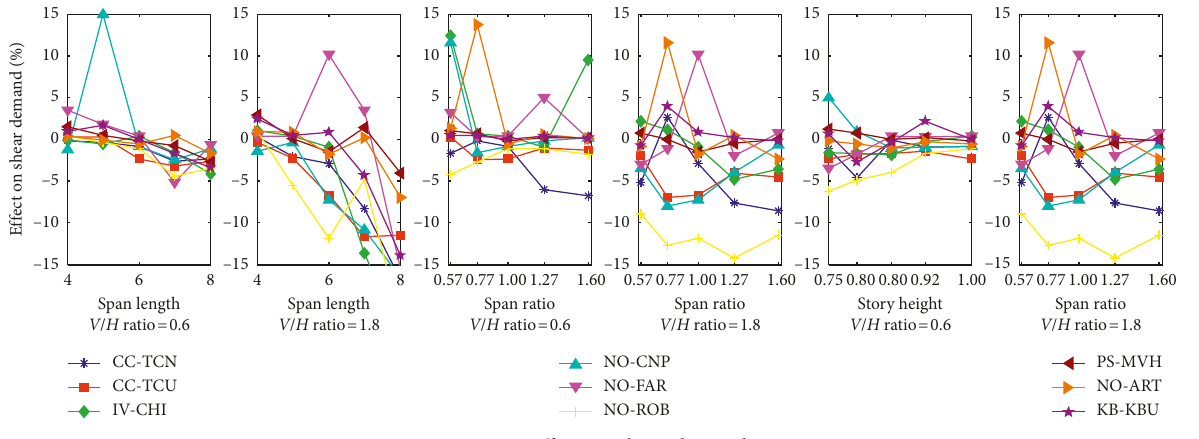
Figure 8: Effect on shear demand.